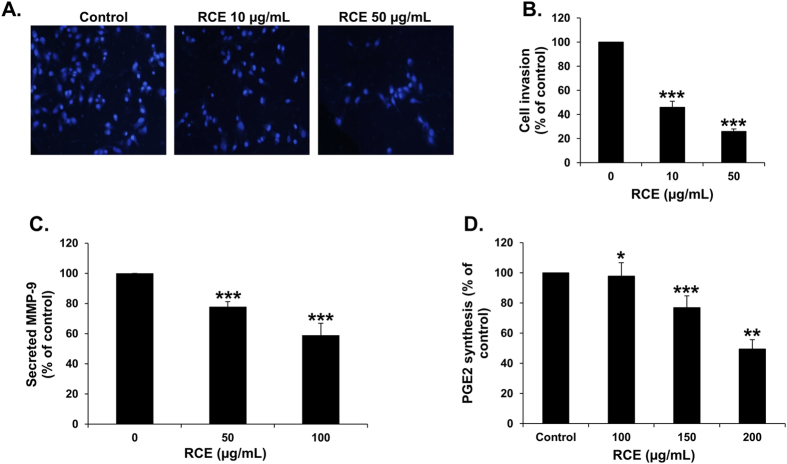
Rhus coriaria inhibits the invasion, downregulates MMP-9 and prostaglandin E2 (PgE2).(A) MDA-MB-231 cells were incubated for 24 h with or without RCE (10 and 50 μg/mL). Cells that invaded into the matrigel were scored as described in Materials and Methods. DAPI-stained nuclei of invading cells were photographed at X 100 magnification under an inverted microscope (Nikon Ti-U, Nikon). (B) Quantification of invaded MDA-MB-231 into the matrigel. Values represented in percent were calculated from three independent experiments and are represented as mean ± SEM. Statistical analysis was performed using one-way ANOVA (*p < 0.05, **p < 0.005, ***p < 0.001). (C,D) Effects of RCE on the secretion of MMP-9 (C) and PgE2 (D) in RCE-treated MDA-MB-231 cells. The levels of secreted MMP-9 and PgE2 were determined using immunoassay kits as described in Materials and Methods. Experiments were repeated three times in triplicate and the average of three means is represented ± SEM. Statistical analysis was performed using one-way ANOVA (*p < 0.05, **p < 0.005, ***p < 0.001).